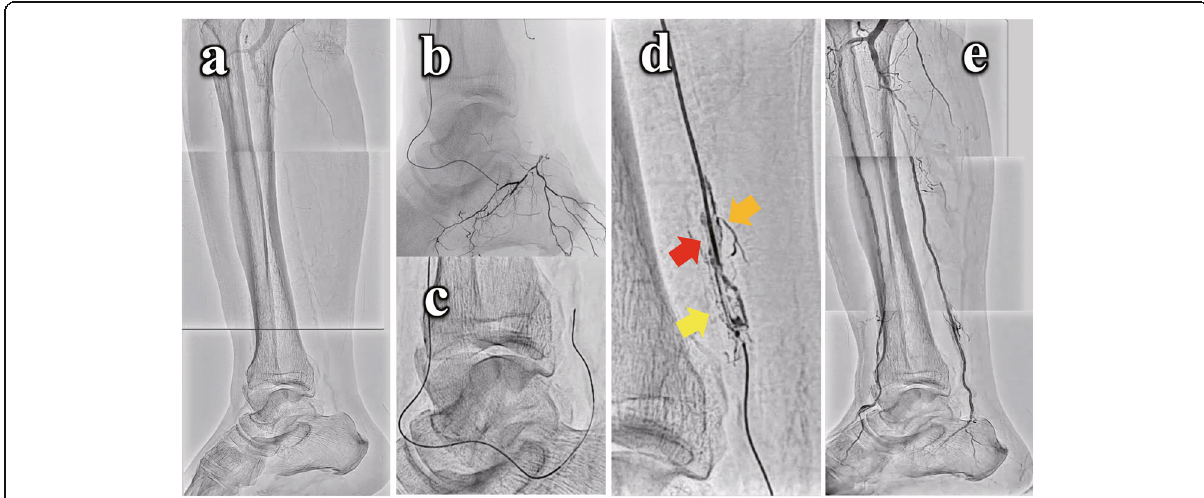
Fig. 3 Angiography of blow-the-knee arterial occlusion treatment with the “ DIOL ” fashion in case 2. A Control angiography of below-the-knee arterial occlusions. B , C . After antegrade wiring for posterior tibial artery (PTA) occlusion, trans-collateral approach was achieved from dorsalis pedis artery through medial plantar artery to PTA. D Retrograde-DIOL was used to realize the position of retrograde microcatheter, visualize a vessel road, and modify the CTO plaque. Microchannels (yellow arrow), the branch (orange arrow), and a tubular dissection (red arrow) were visualized. E A direct blood flow to the wounds was obtained with balloon